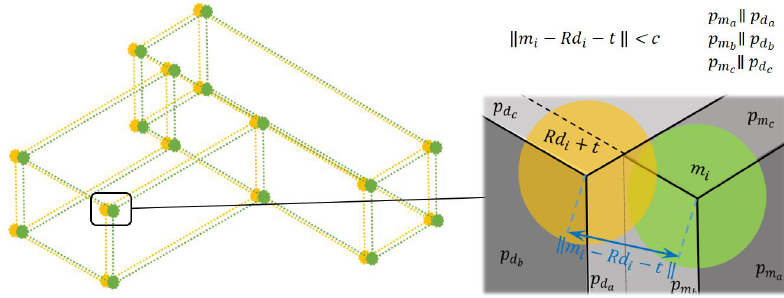
Figure 10 . An example of neighbor corner points with parallel parent planes.